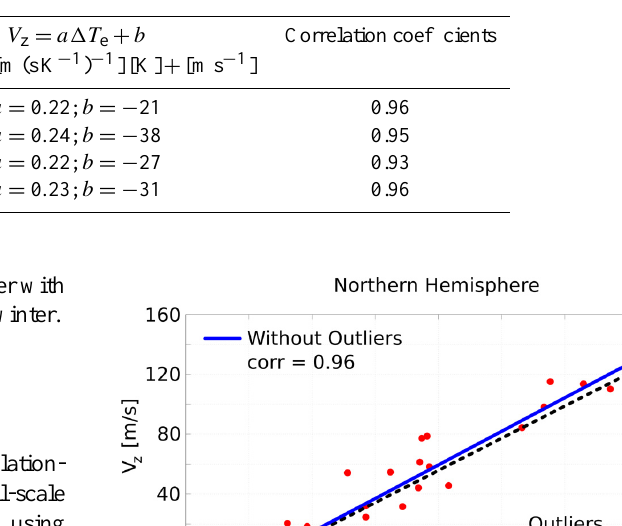
Table 2. Correlation analysis between the ion vertical velocity V z and electron temperature rise 1T e in the Northern Hemisphere. The linear regression functions V z = a1T e + b and correlation coefficients for the seasons separately and for all seasons together, where a is a slope and b is an offset.